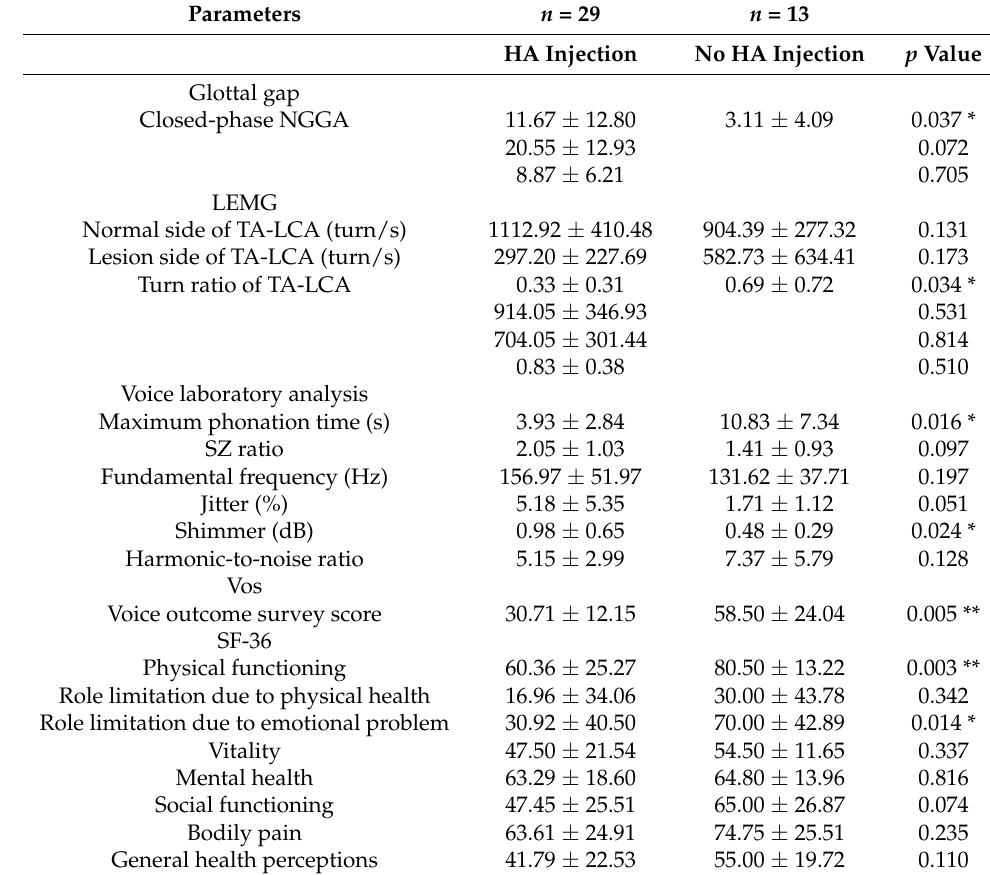
Table 3. Comparison of the characteristics of patients with UVFP who did or did not undergo immediate injection